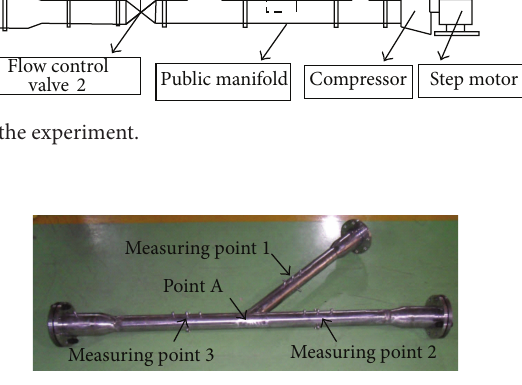
Figure 3: Photograph of the